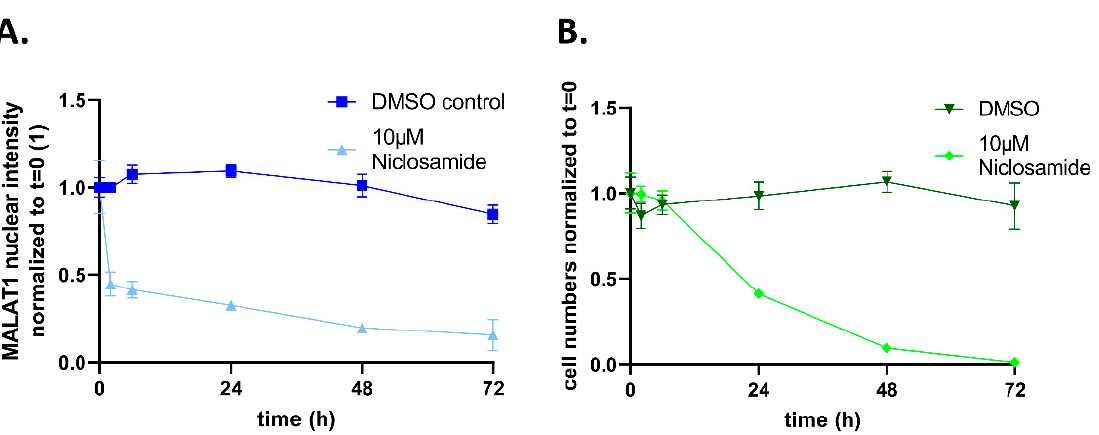
Figure 8. ( A ): Time course of MALAT1 nuclear intensity decrease and ( B ). effect on nuclear numbers. Hela cells were treated with DMSO or 10 µM Niclosamide and MALAT1 was stained by FISH. Nuclear MALAT1 levels and number of nuclei per well were determined. Mean of n = 4 per condition and timepoint with SD as error bars.